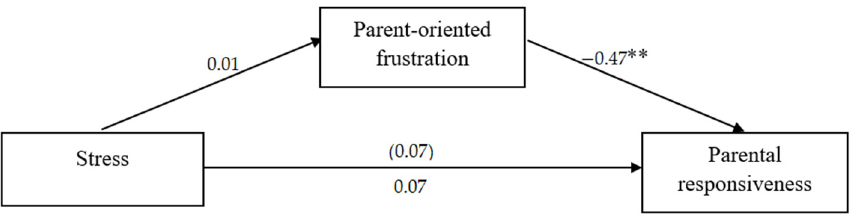
Figure 3. Mediation model for men (standardized coefficients are reported; total effect in parenthesis). Note. ** p < 0.01.